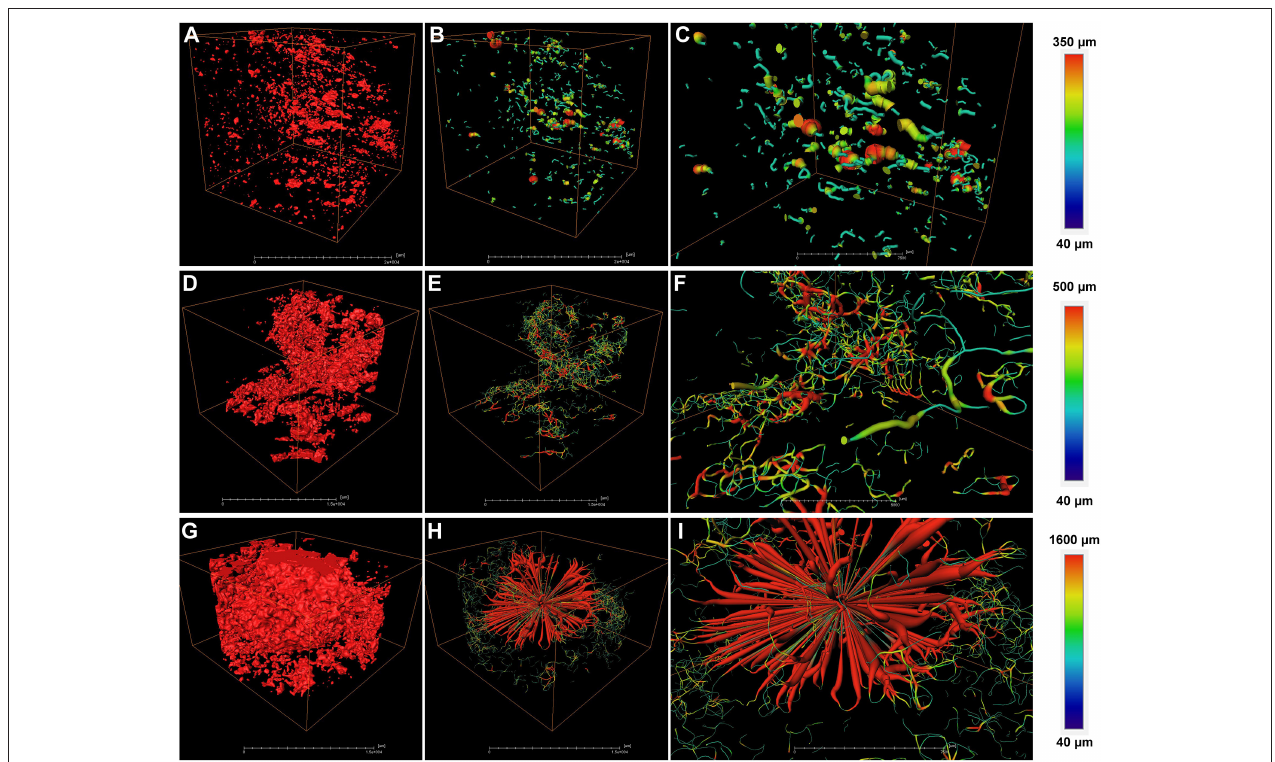
FIGURE 5 | Network skeleton analysis of specific areas of “Akizuki” fruit. (A) Pore analysis of the HRA (high-risk area with cork spot) and MRA (middle-risk area with cork spot) of healthy fruit. Red dots represent pores based on the grayscale value threshold. (B) Reconstructed 3D network model of (A) . (C) Closer view of (B) . (D,G) Pore analysis of the MRA and HRA of cork spotted fruit, respectively. Red dots represent pores based on the grayscale value threshold. (E,H) Reconstructed 3D network models of (D,G) , respectively. (F,I) Closer view of (E,H) , respectively. Color bars on the right indicate pore thickness from narrow (blue) to wide (red).